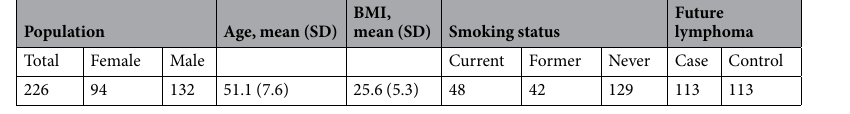
Table 4. Study population